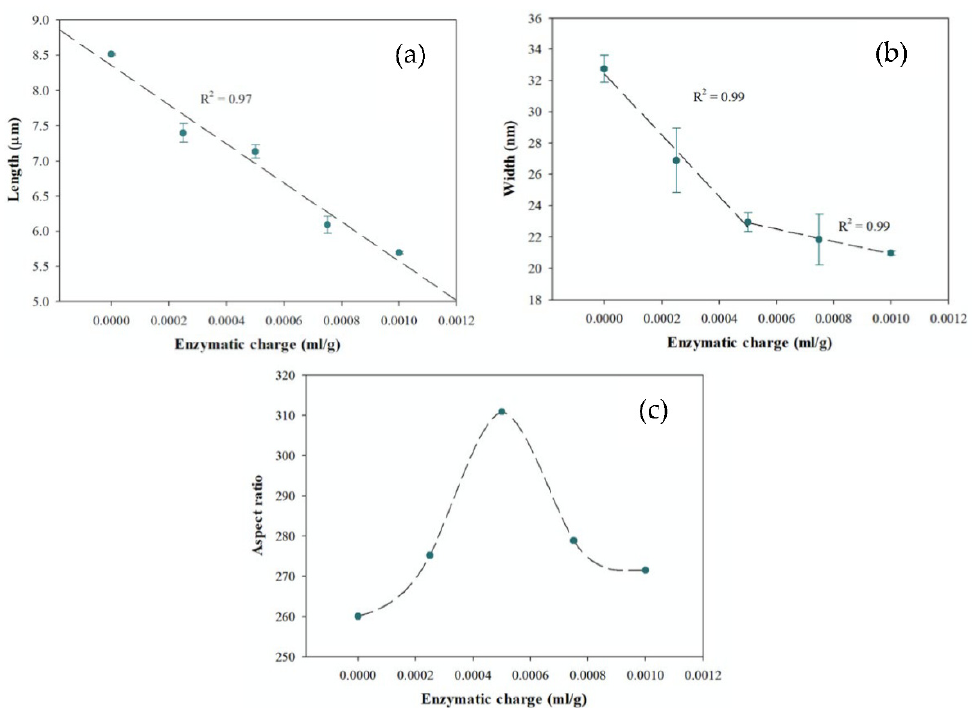
Figure 2. Morphological characteristics of the CNFs as a function of the enzyme charge in the second enzyme pretreatment: ( a ) length, ( b ) width, and ( c ) aspect ratio.